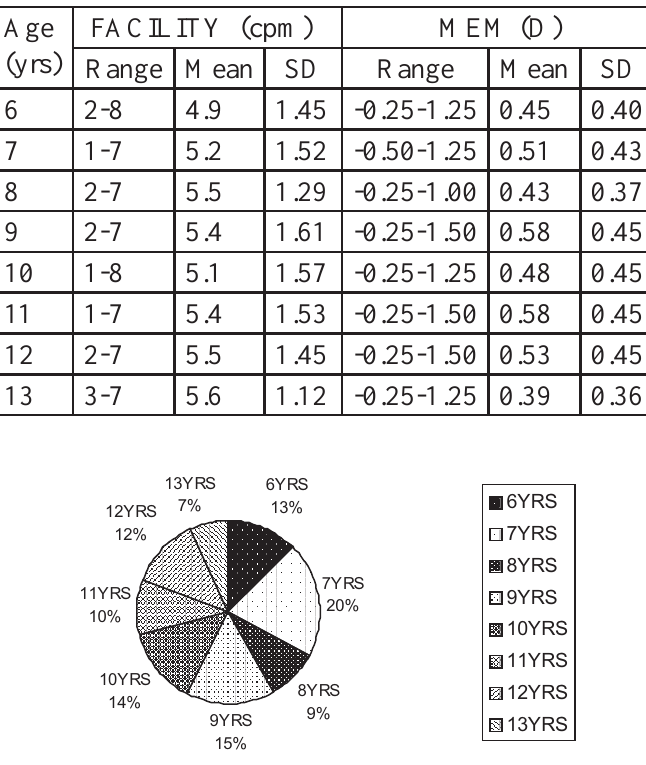
FIGURE 1: PROFILE OF SUBJECTS (N=264)